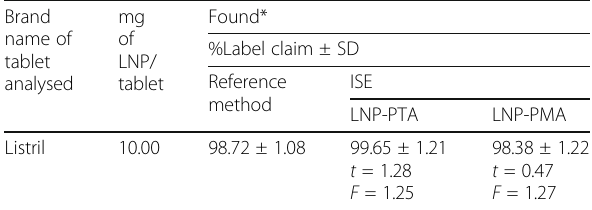
Table 6 Results of analysis of tablets using proposed ISEs and statistical comparison of the results with the reference method